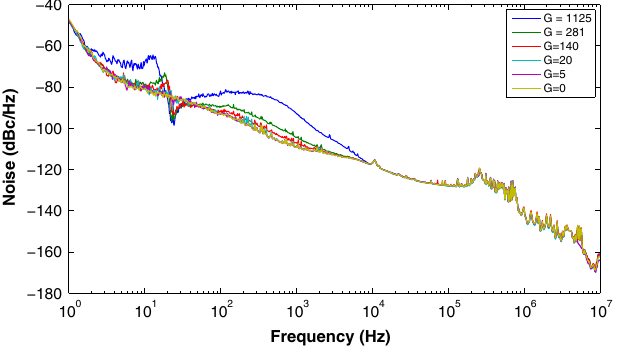
FIG. 5. The rf station 6B2 noise spectral density with BPL gain.